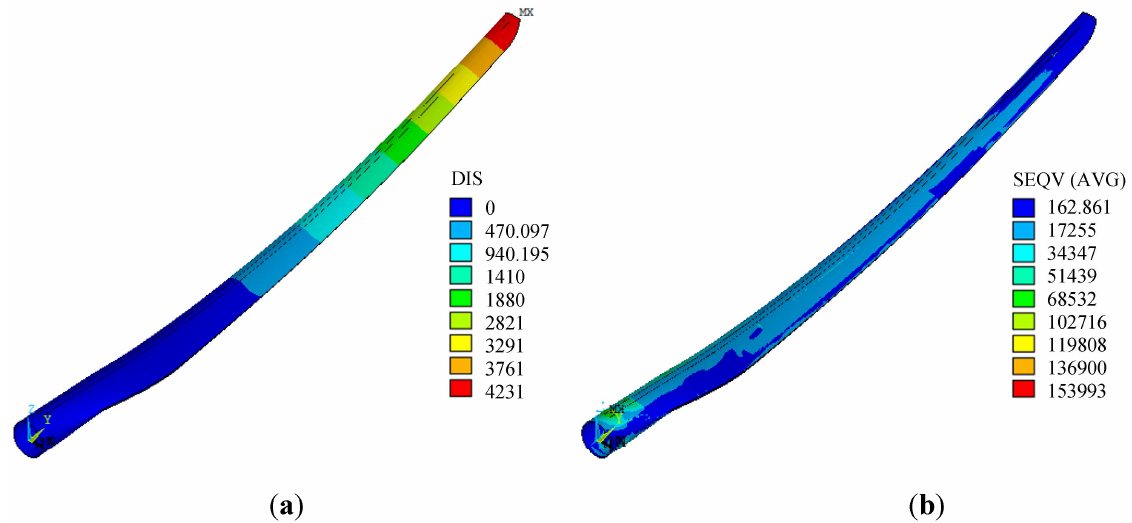
Figure 10. ( a ) The flap-wise deflection of the blade; and ( b ) The Von Mises stress distribution of the